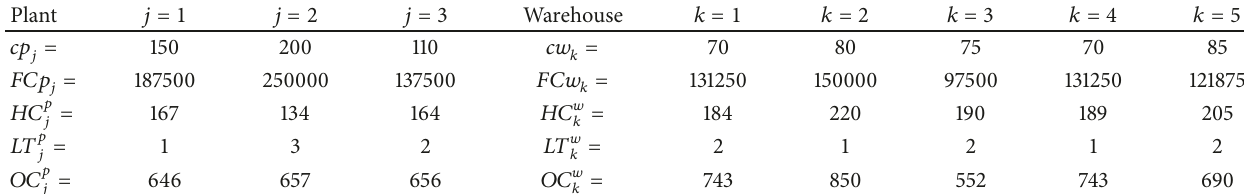
Table 2: Parameters of the base case, associated with plants 𝑗 , and warehouses 𝑘 .